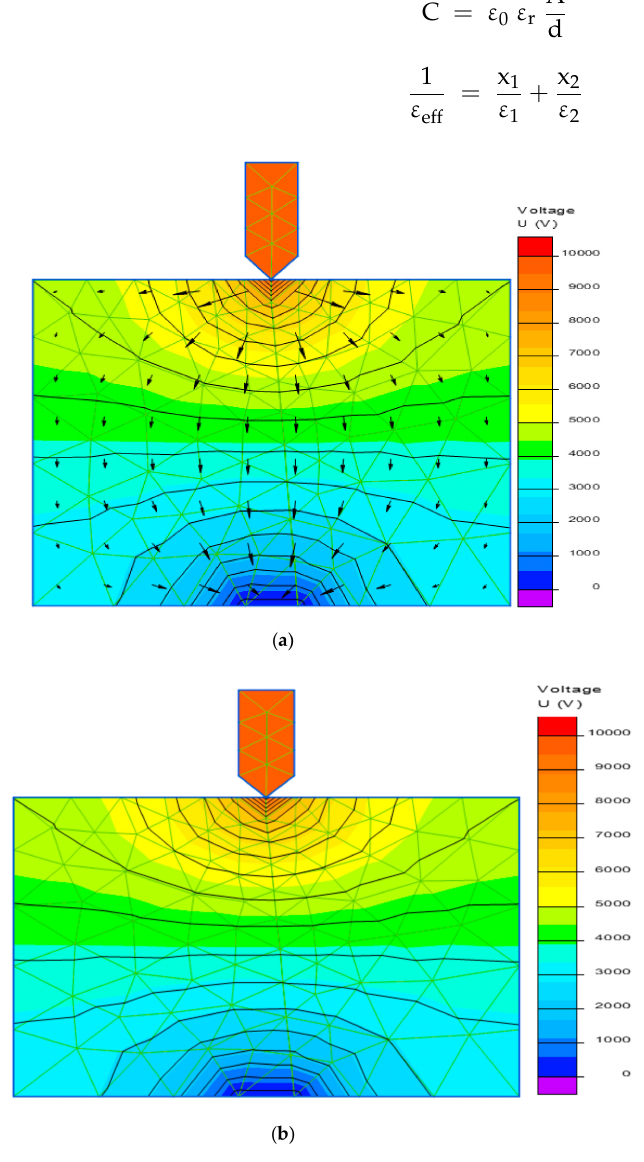
Figure 9. Voltage showing ( a ) with vectors of electric field strength ( b ) and without electric field